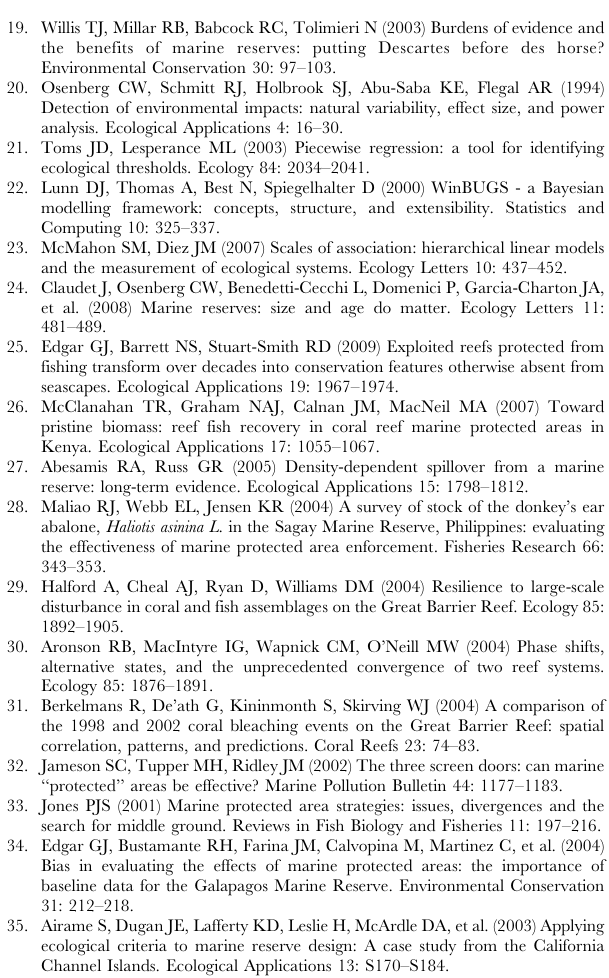
Figure S3 AIC values for all models examined. The best model is the one with the smallest AIC value. In this case, the best model is one in which MPA modifies the slope and intercept and ocean modifies the intercept only. Models with AICs that exceed 18650 are designated with arrows. Figure S4 Coefficient estimates for the MPA versus non-MPA model. The 95% credibility intervals (thin light grey line) and the 50% credibility intervals (thick dark grey line) as well as point estimates (median) of the posterior distributions for all parameters in the MPA versus non-MPA model using a Bayesian approach to fit the model. There is a 95% probability that the true value lies within the 95% credibility interval. The MPA x 10-Year Trend term should be contrasted with the 10-Year Trend term, which is the trend for non-MPAs. The MPA x 10-Year Trend term is an effect and gets added to the 10-Year Trend term when MPA= 1 to obtain the trend for MPAs. Figure S5 Generalized additive mixed models (non-parametric estimation) for the (A) Caribbean and (B) Indo-Pacific. There is no evidence of a changepoint in the Caribbean, but there is in the Indo-Pacific. The 95% confidence intervals are shown with dashed lines. The models have been smoothed with a 5-year running mean.